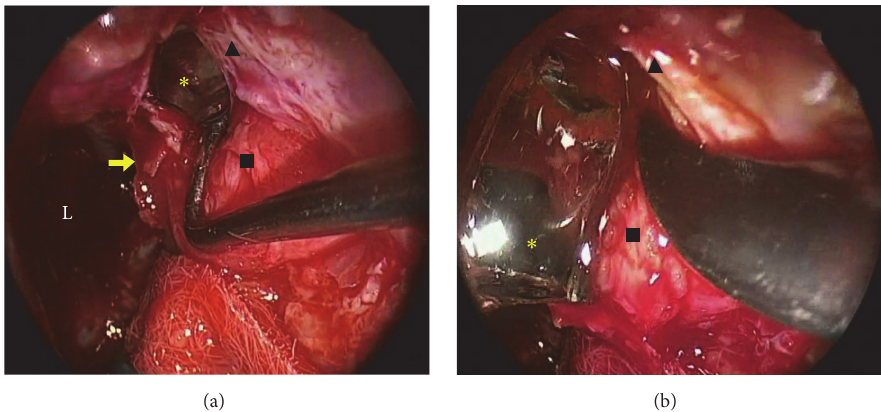
Figure 2: (a-b) Left transnasal endoscopic view of a shard of glass (yellow asterisk) following the aperture of the lamina papyracea (yellow arrow) and left periorbital fat (black square) immediately behind the nasolacrimal duct (black